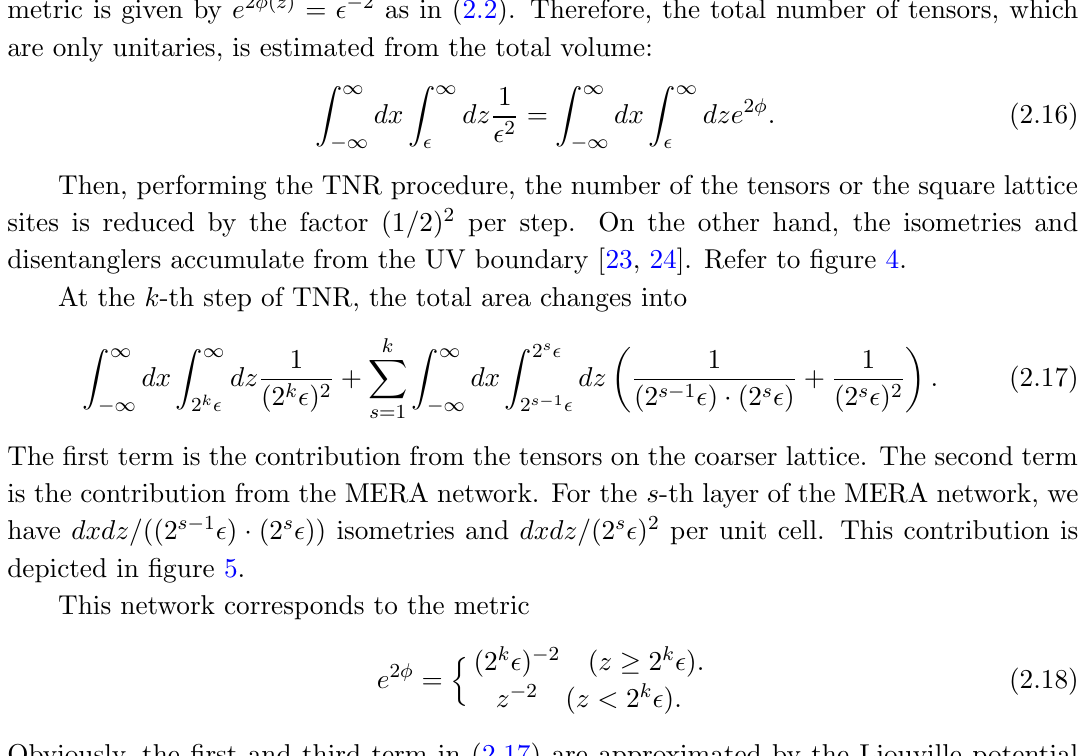
s (cid:15) dz ( (cid:1) (cid:1) (cid:1) ) in 2 s (cid:0) 1 (cid:15)